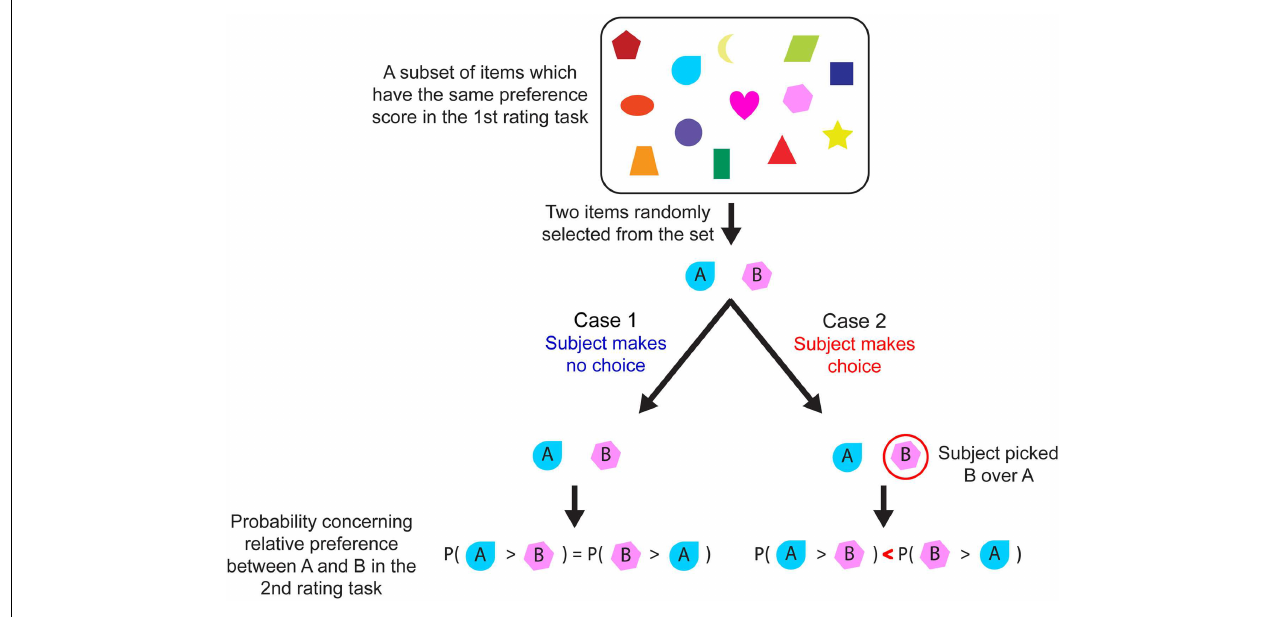
be rated higher during the second rating task. In contrast (Case 2), the participant’s choice provides additional information about his/her relative preference between the two items.Thus, if a participant selected B over A, item B (chosen item) is likely to be rated higher than item A (rejected item) during the second rating task (i.e., a spread of alternatives is more likely to be